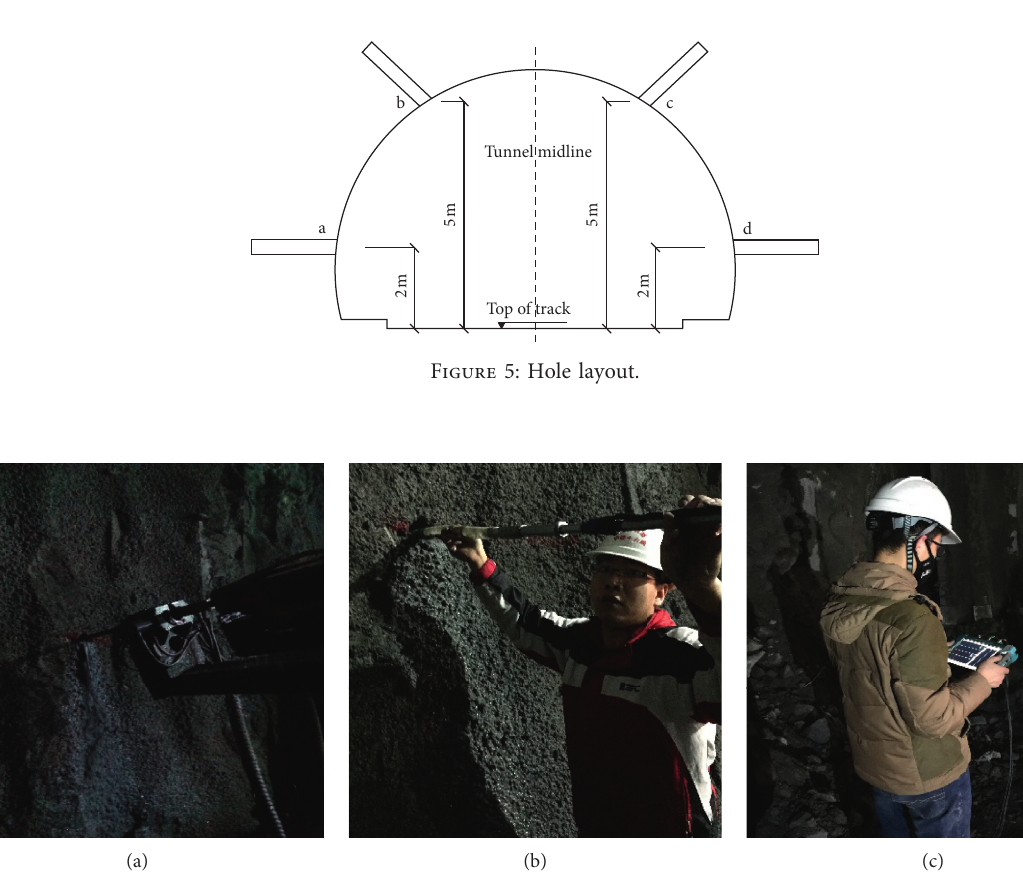
Figure 6: Field test of the loose circle. (a) Drilling holes, (b) installing probes, (c) collecting data.